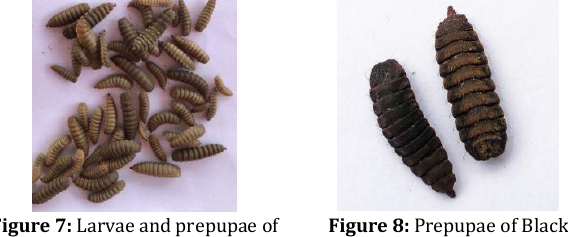
Figure 7: Larvae and prepupae of Black soldier fly extracted from waste bin (after cleaning)